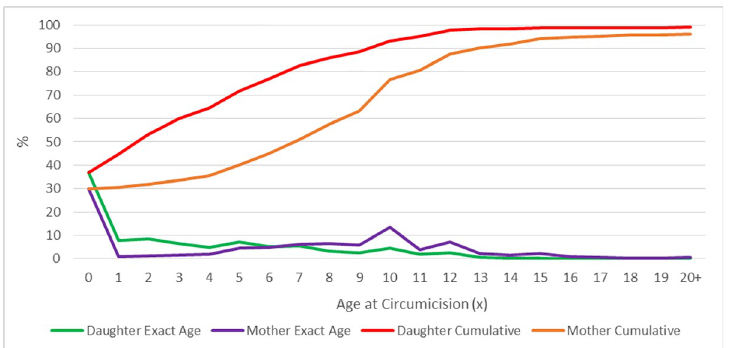
Fig 4. Comparison of mothers’ and daughters’ age at FGM.